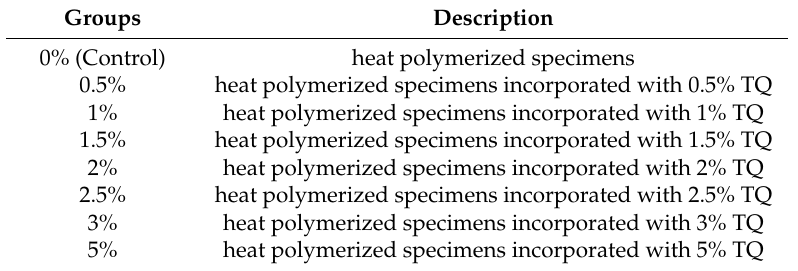
Table 1. Tested groups and description according to thymoquinone (TQ) concentrations.